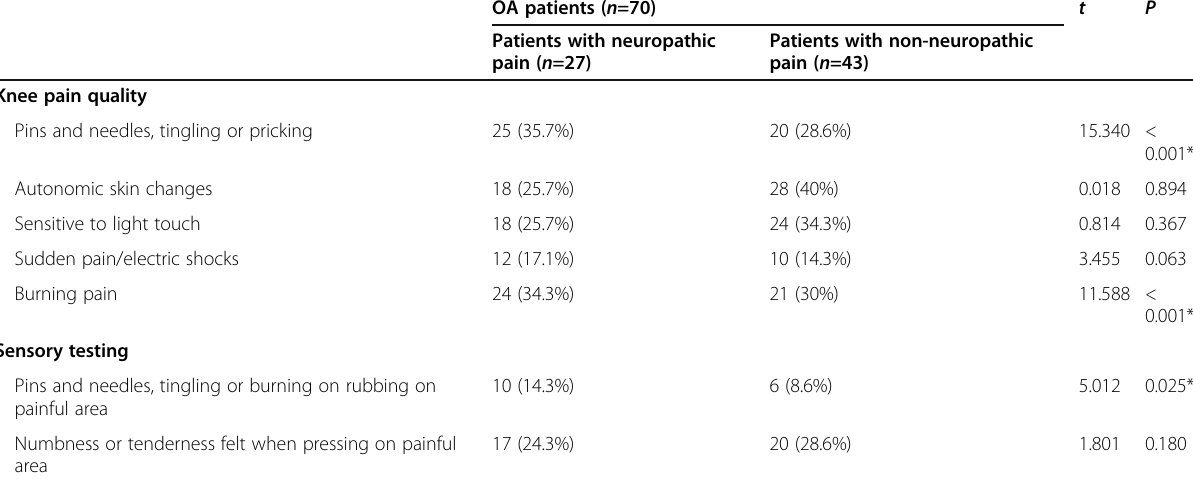
Table 3 The frequency of responses for individual items of LANSS questionnaire among OA patients